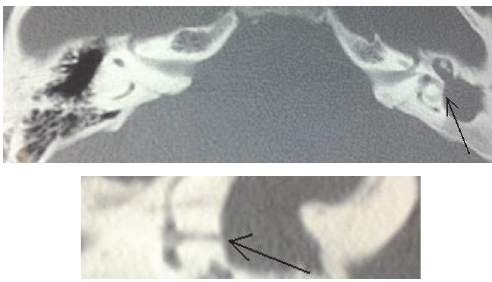
Figure 1: Case 1 . Two different sections in the CT scan showing the fistula of the left horizontal semicircular canal and the middle ear filled with cholesteatoma and inflammatory tissue.